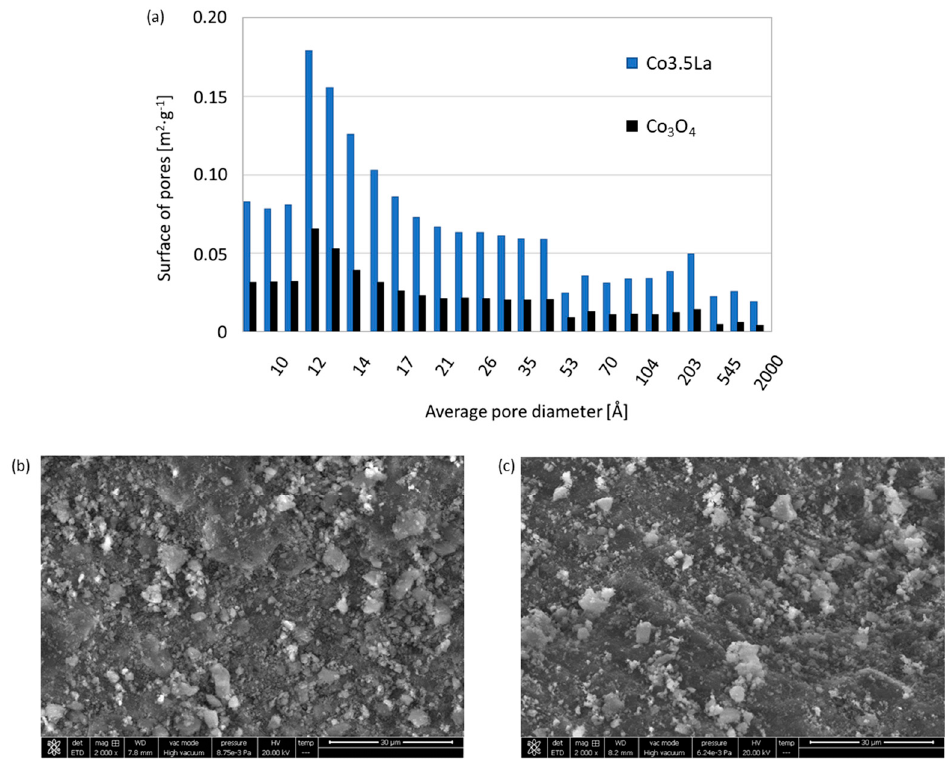
Figure 3. Results of characterization studies: ( a ) porosimetry test results for the fresh undoped cobalt catalyst (black) and Co3.5La (blue) and SEM images of Co3.5La ( b ) fresh and ( c ) after catalytic tests.